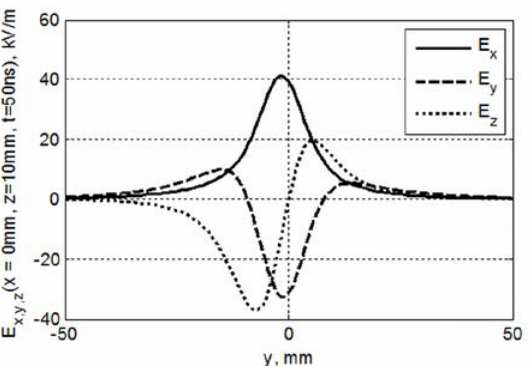
Figure 18: Calculated electric field components E x , E y and E z for the dipoles in Figure 14 along the line z = 10 mm, x = 0 and at the instant time t = 50 ns.